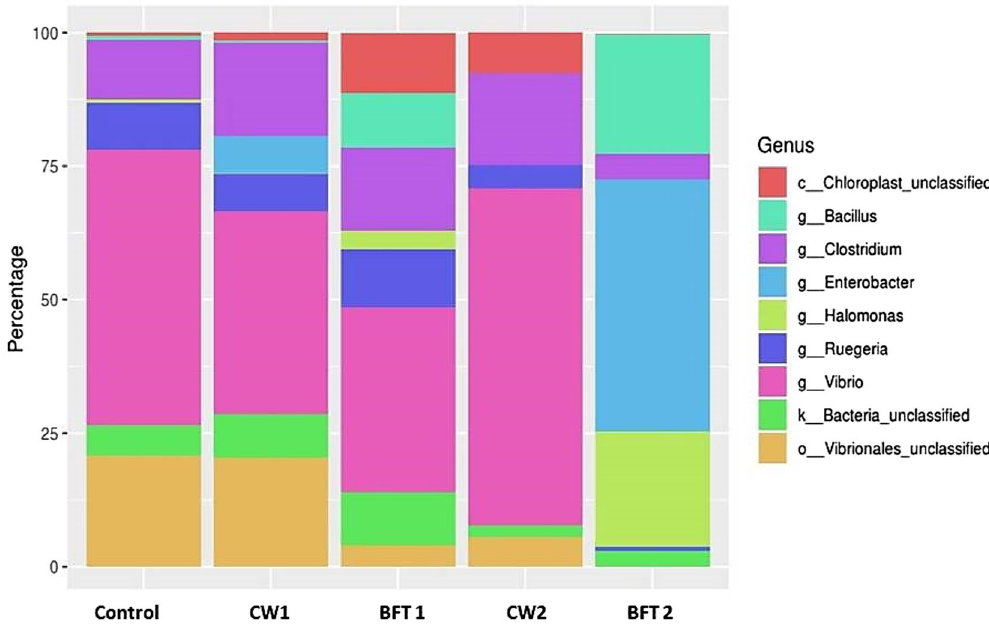
Figure 2. Dominant species abundance